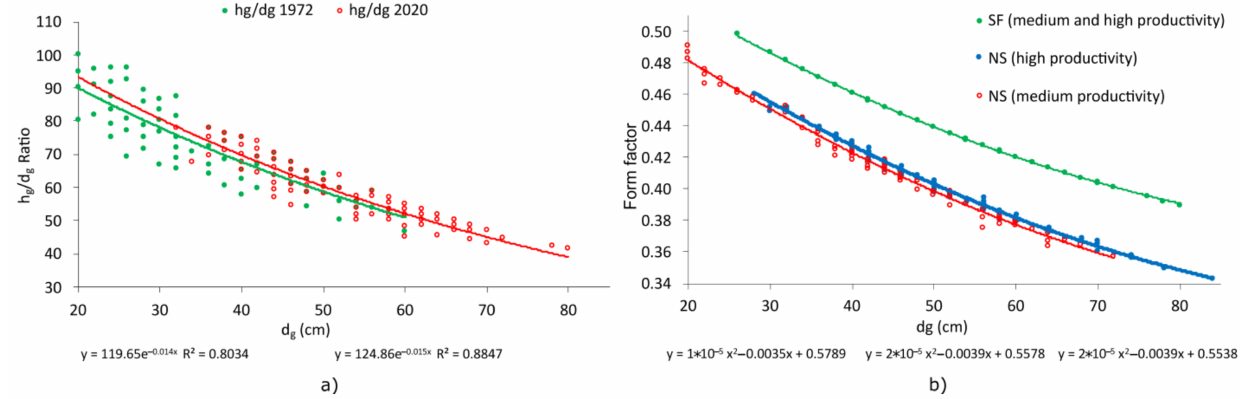
Figure 5. Tendency of the slenderness index of the stands, calculated at the level of 2020 compared to 1972, for fir ( a ), and variation in the form factor in relation to diameter (i.e., d g ) for fir and spruce at the 2020 level ( b ). The form factor values were deduced from the mean-tree volumes (i.e., from the volume of the mean-basal-area trees) (SF—silver fir, EB—European beech, and NS—Norway spruce).